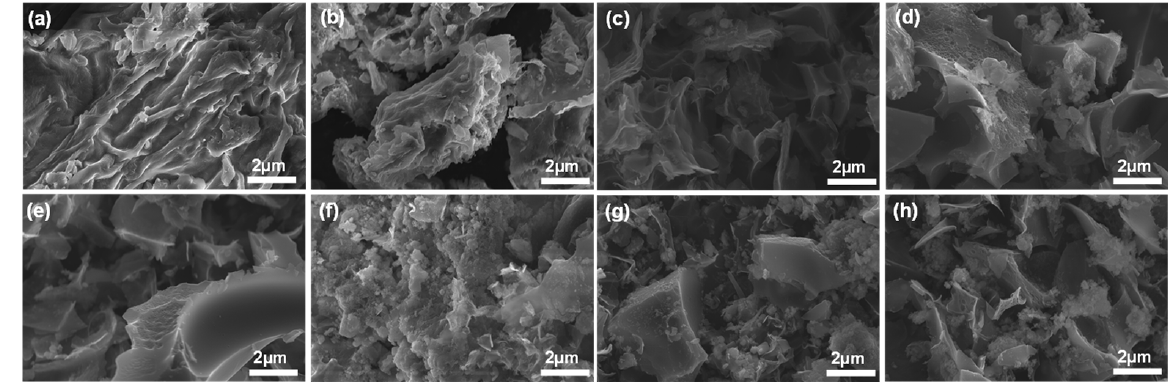
Figure 1. SEM images of ( a ) raw black tea, ( b ) hydrochar, ( c ) BTC-612, ( d ) BTC-613, ( e ) BTC-614, ( f ) BTC-712, ( g ) BTC-713, and ( h ) BTC-714 (denoted as BTC-XY where X indicates the activation temperature, that is, 6 for 600 ◦ C and 7 for 700 ◦ C and Y is the mass ratio between hydrochar and KOH).